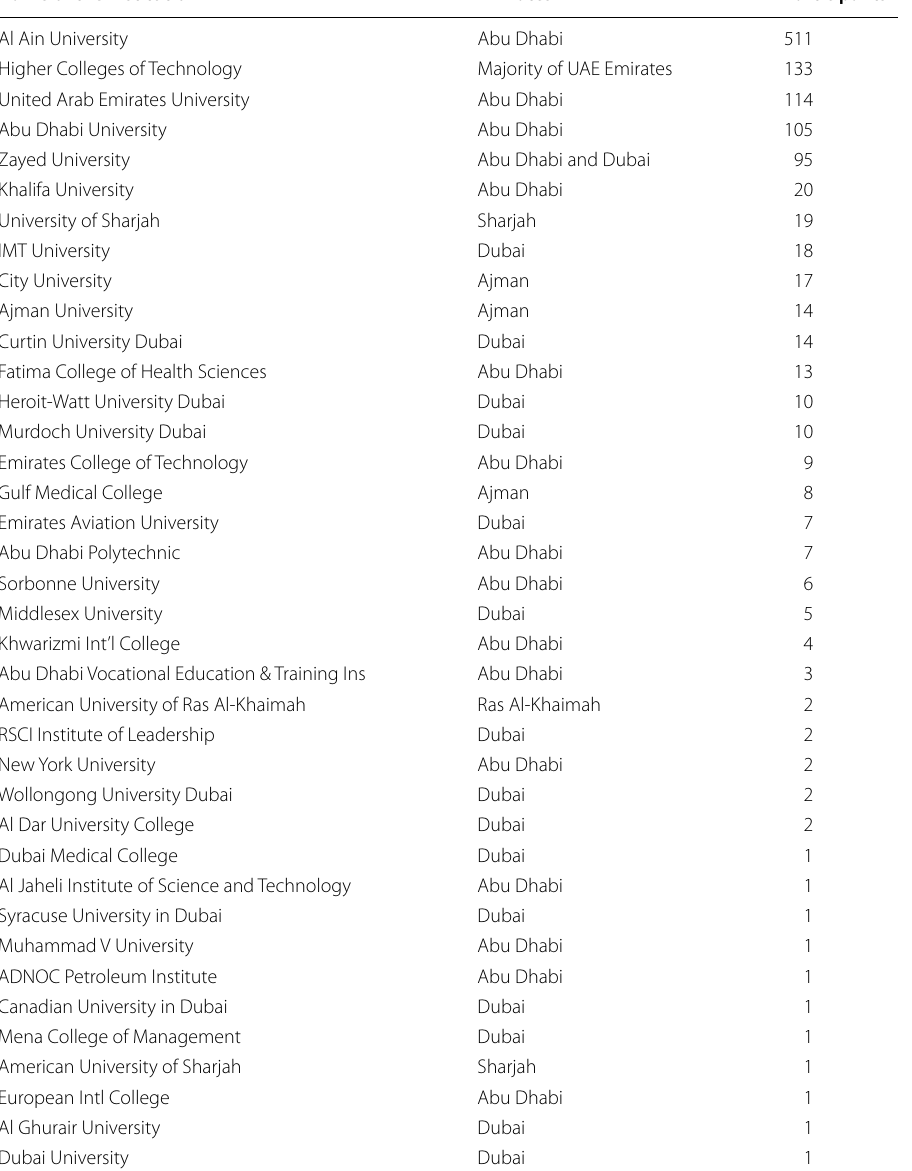
Table 2 University-wise students’ participation